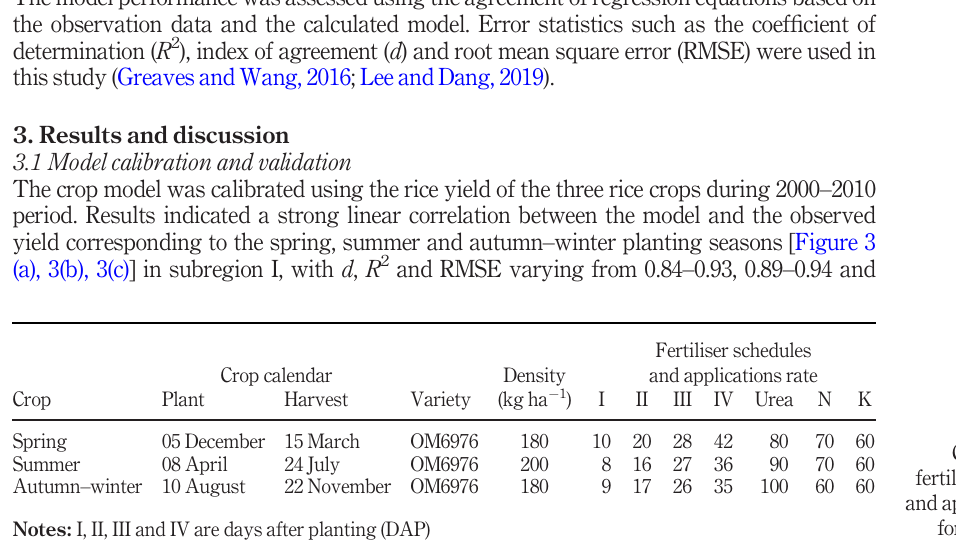
Table 2. Crop calendar, fertiliser schedules and application rate for rice